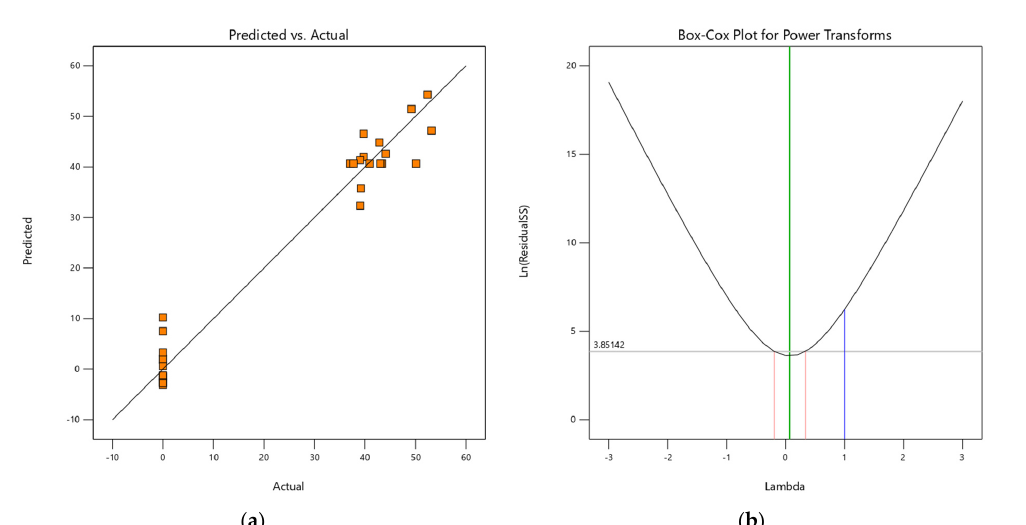
Figure 11. ( a ) Actual values vs. predicted values and ( b ) Box–Cox plot power transforms for Cu(II) loaded onto H + Dowex-M4195 chelating resin from the selected quadratic model terms. Figure 12a–d denote the normal plot of residuals, Cook’s distance, residual vs. predicted and residual vs. run plots, respectively. Figure 12a implies that the normal probability plots produced a good correlation with a straight line that assured the model term had significance. Figure 12b illustrates Cook’s distance plot; it can be observed that each run number was lower than the red straight-line plot (<1), indicating strong influence of fitted values of the selected quadratic model. In addition, other statistical tools such as residual vs. predicted and residual vs. run plots were also used to confirm the selected model. It can be seen that distributed data points did not detect outliers of the red straight- line plots (3.87982). It is suggested that the selected quadratic model is accurate and adequate for the selection of copper removal via an ion exchange process with the selected chelating resin for sustainable water reuse and can be applied in engineering water treat- ment process design.